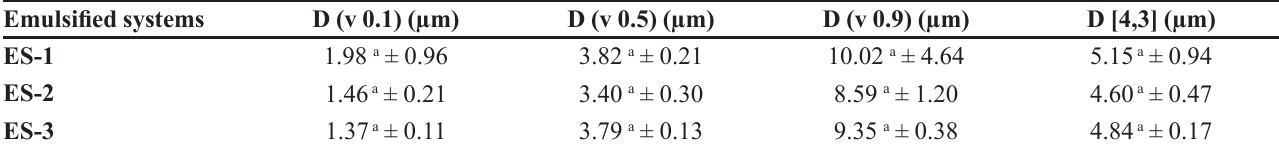
TABLE III - Droplets distribution on the inner phase of the emulsified systems, measured by laser diffraction Emulsified systems